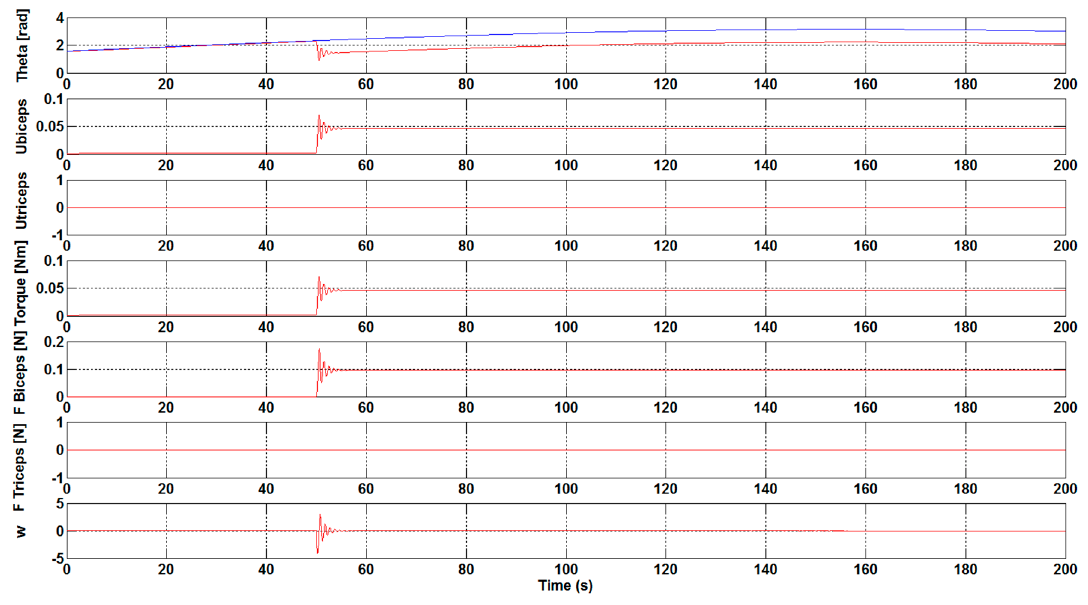
Figure 7. Results without the optimization algorithm and with the application of a load.